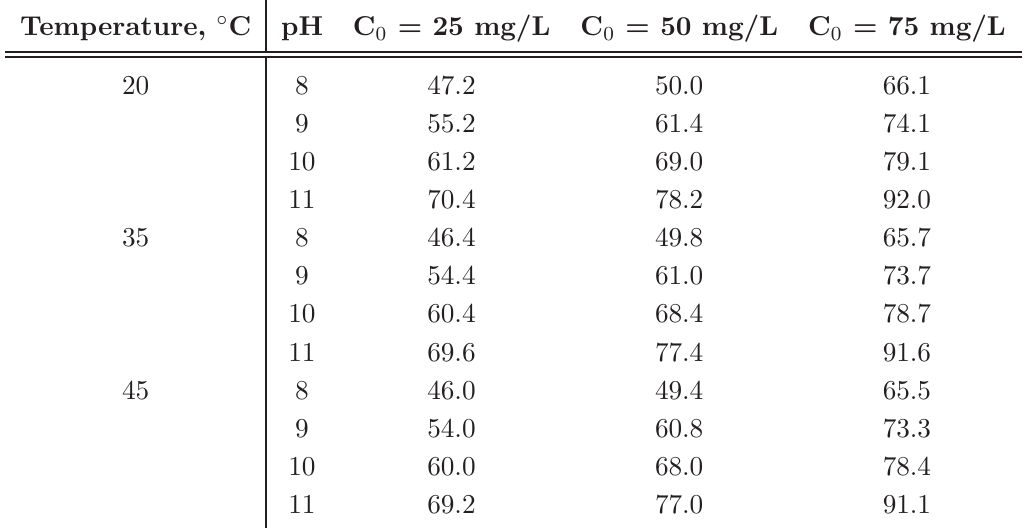
Table 2 Oxidation yields (%) obtained at various conditions in the solution without packing.